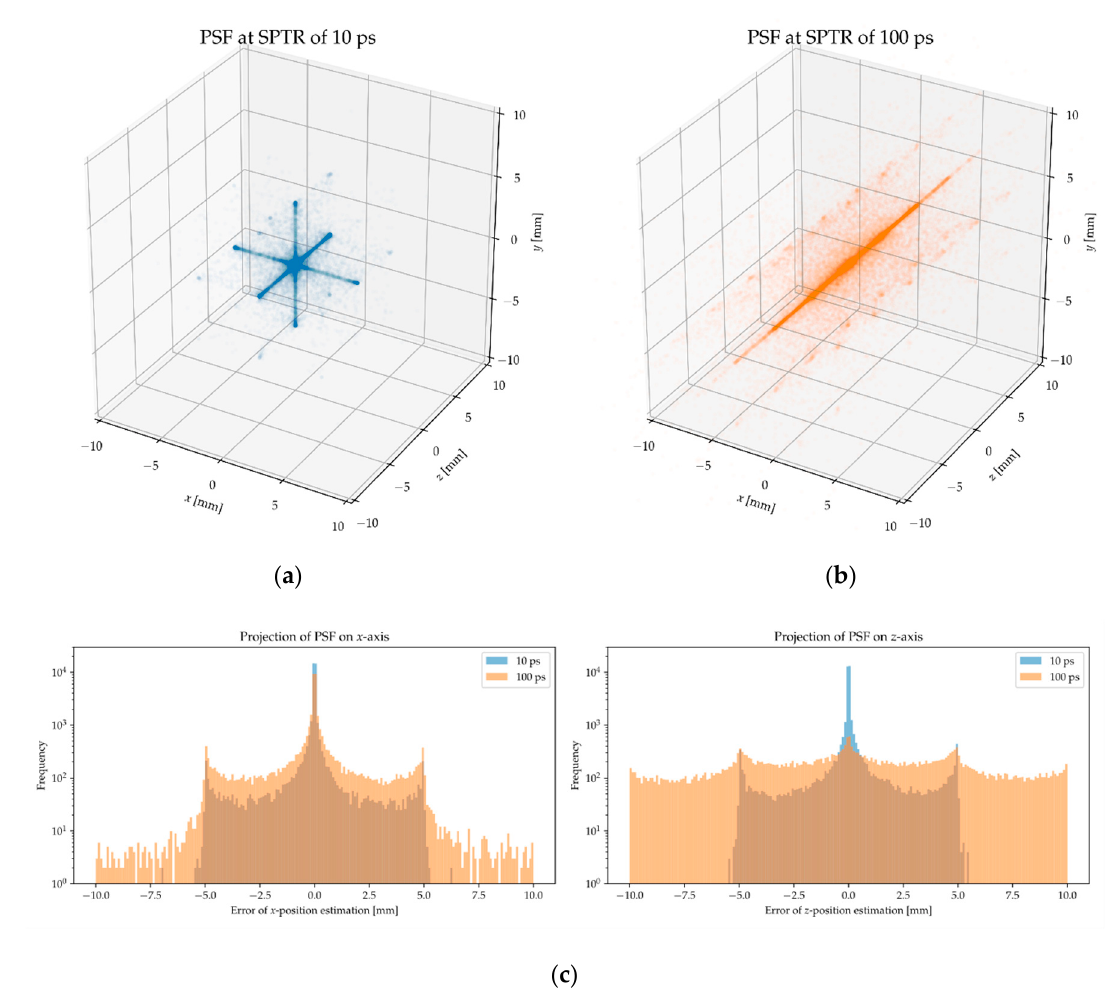
Figure 6. Point spread function (PSF) as an error distribution between the true and estimated source position at an SPTR of ( a ) 10 ps and ( b ) 100 ps, respectively. ( c ) Projection of PSF on the x -and z -axes. Results on the y -axis were omitted because they were very similar to those on the x -axis. Readout pitch was fixed at 3 mm.